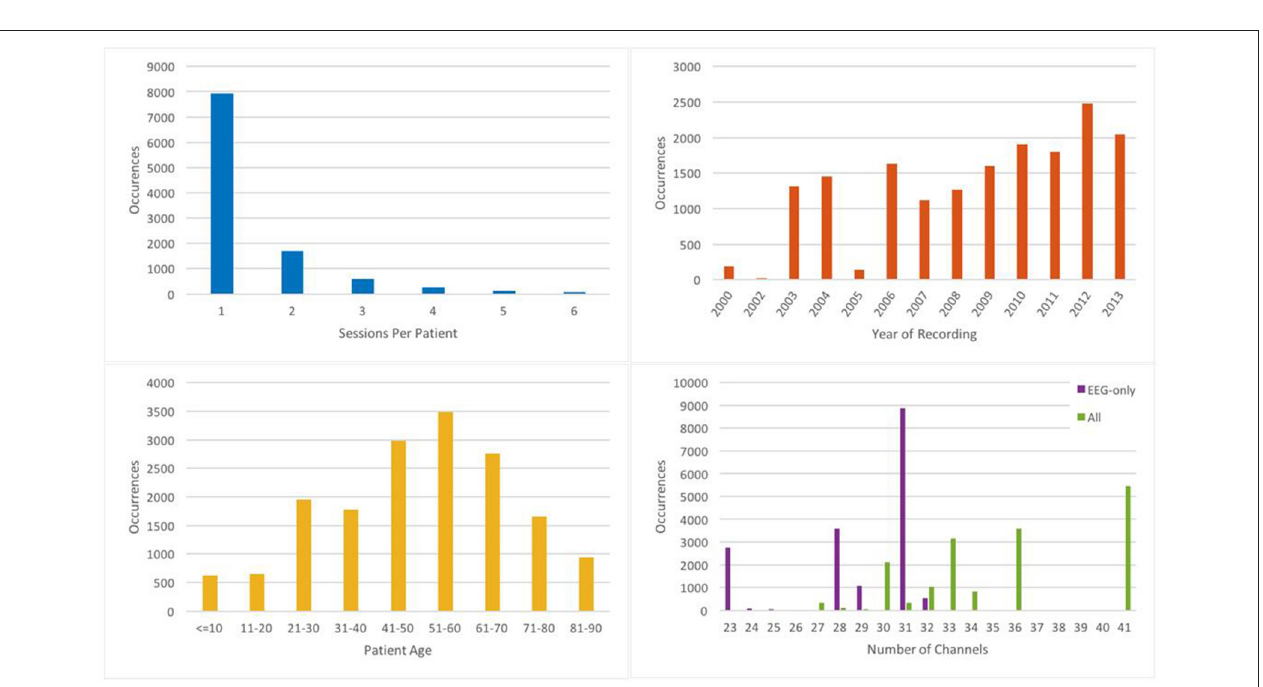
(1) spike and/or sharp waves (SPSW): patterns of EEGs observed during epileptic